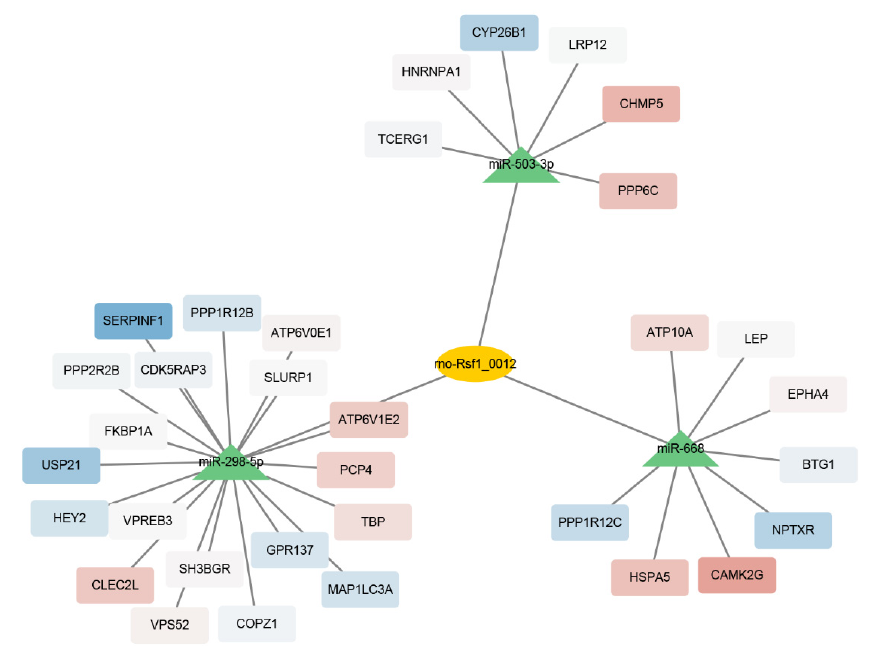
Figure 4. ceRNA network of rno-Rsf1_0012 with mRNAs. CircRNA rno-Rsf1_0012 and binding miRNAs are denoted by orange ellipse and green triangles, respectively. According to the trend of mRNA differential expression, the up-regulated and down-regulated mRNAs are denoted by red and blue rectangles, respectively.